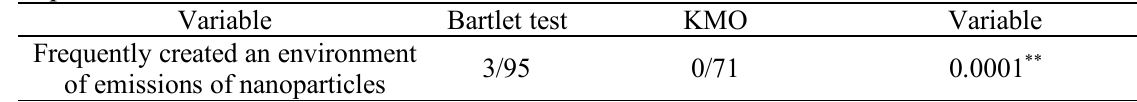
Table 7. Varimax rotation test responses to the environment caused by the release of